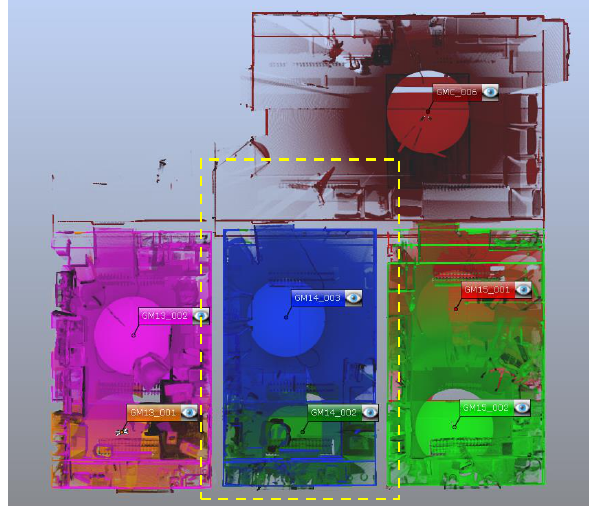
Figure 8. Faro scan positions after registration in Faro Scene; yellow dashed box indicates final cropped benchmark